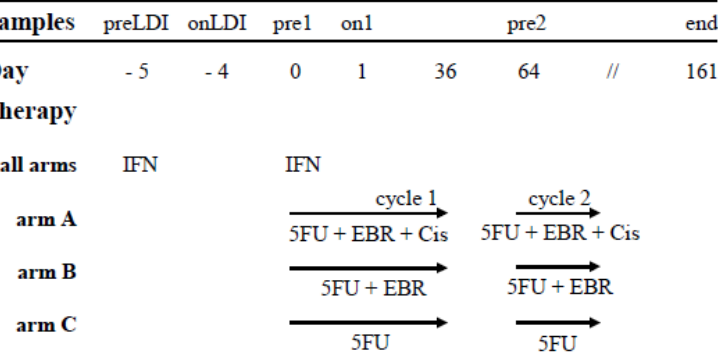
Figure 1. CapRI-2 therapy schema and time-points of blood withdrawal during the therapy. Blood samples were taken from the patients immediately before the first IFN injection (pre low-dose IFN (preLDI)), one day after (onLDI), immediately before the start of the first cycle of chemo-radio-immunotherapy or chemotherapy (pre1), one day after (on1), before the start of the second cycle of chemo-radio-immunotherapy or chemotherapy (pre2) and after a third cycle of the therapy (end). EBR—external beam radiation,